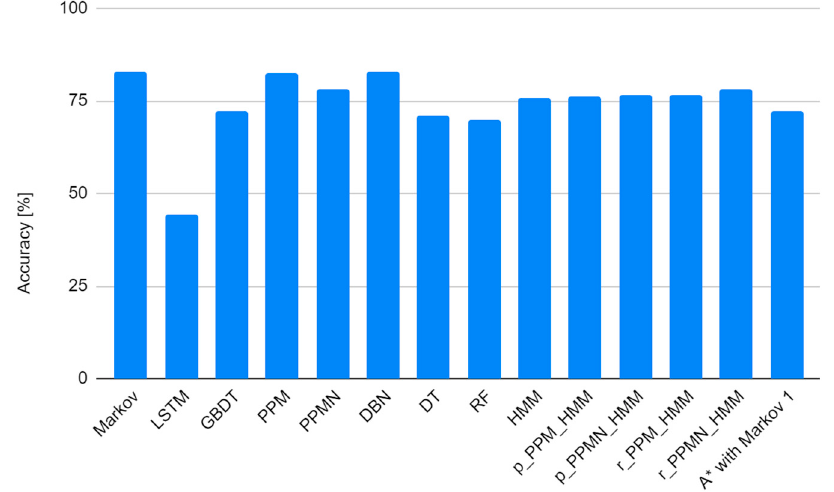
Figure 15. Accuracy on the workers’ dataset.